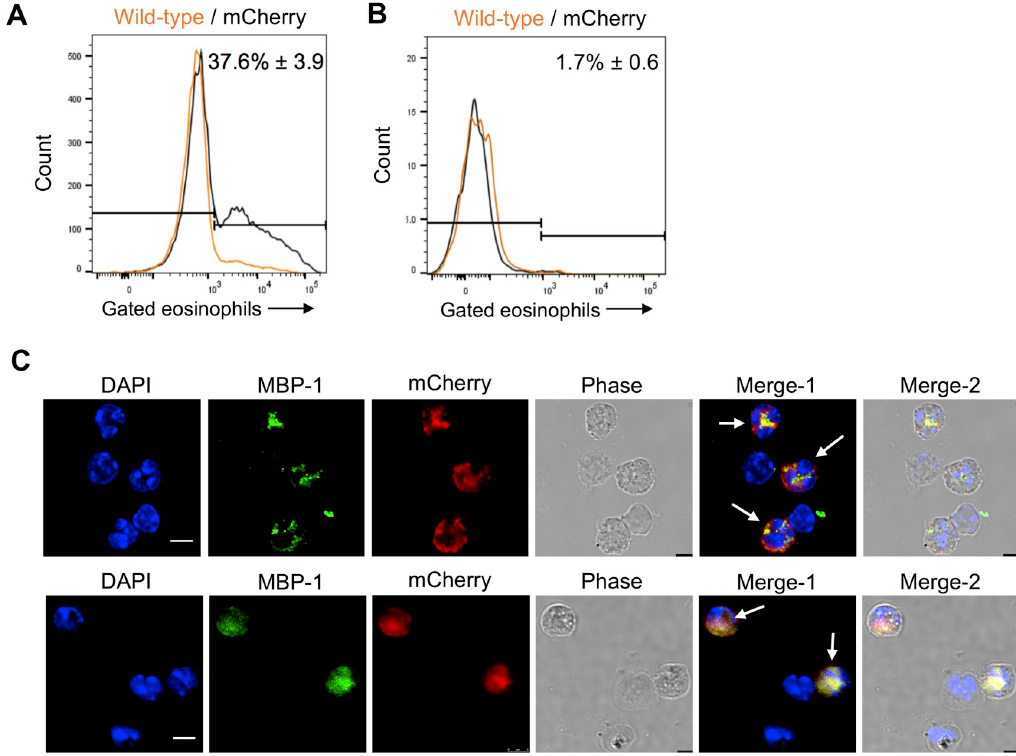
Fig 3. ROR γ t expression in lung eosinophils assessed using ROR γ t-mCherry reporter mice. (A) Flow cytometry (allergy model) . Allergic aspergillosis was induced in wild-type and ROR γ t-mCherry reporter mice as in Fig 1A. Eosinophils from lung cells were analyzed for expression of the mCherry signal. The plot demonstrates representative histograms of gated eosinophils from wild-type (orange) and ROR γ t-mCherry reporter (black) mice, respectively. The mean ± SE (n = 6 mice) of mCherry- positive eosinophils combining all the reporter mice experiments is shown next to the histogram. (B) Flow cytometry (untreated mice) . Lungs were harvested from untreated wild-type and mCherry mice and their eosinophils were analyzed for mCherry expression. FACS plots are representative of 2 experiments, each with 5–6 mice per group. The mean ± SE (n = 11 mice) of mCherry-positive eosinophils combining all the reporter mice experiments is shown next to the histogram. (C) Confocal microscopy . Upper Panel: BAL cells were harvested from ROR γ t-mCherry reporter mice with allergic aspergillosis induced as in Fig 1A. Cells were permeabilized and stained for the eosinophil marker, MBP (green) and the nuclear marker, DAPI (blue). The mCherry reporter is in red. Merge-1: DAPI + MBP + mCherry, Merge-2: DAPI + MBP + mCherry + Phase. Scale bar = 5 μ m. Lower Panel: ROR γ t-mCherry reporter mice were infected with 5 x 10 7 A . fumigatus conidia. Two days post infection, cells were harvested by BAL and permeabilized and stained as in Fig 3B. Merge-1: DAPI + MBP + mCherry, Merge-2: DAPI + MBP + mCherry + Phase. Scale bar = 5 μ m.